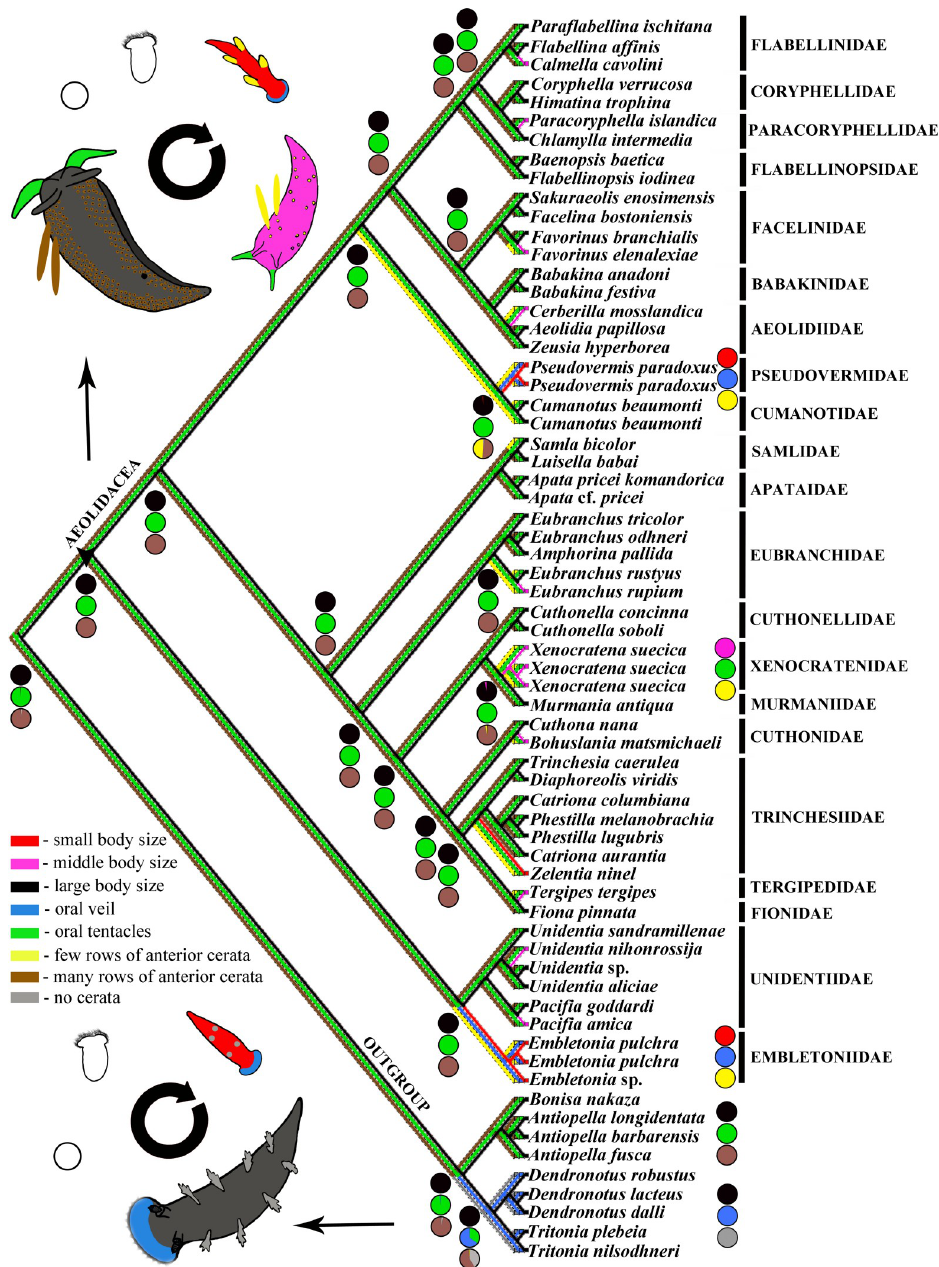
Fig 4. Ancestral state reconstruction for paedomorphic traits based on ML analysis of a concatenated dataset. Eight morphological characters are color-coded for analysis and additionally patterned on developmental stages of ontogenetic cycles. See details in the text. Pie charts represent degree of support for each character state at the nodes. Strongly paedomorphic adults characterized by small size (red), small oral veil (blue) and oral tentacles absent, and small number of anterior ceratal rows